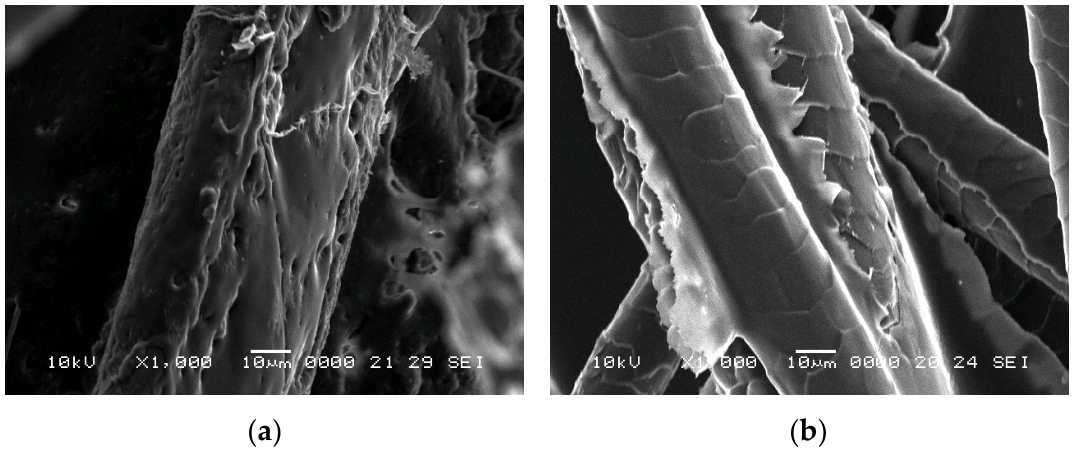
Figure 13. SEM images of wool-binder samples at ×1000 magnification: ( a ) P3; ( b ) P13.